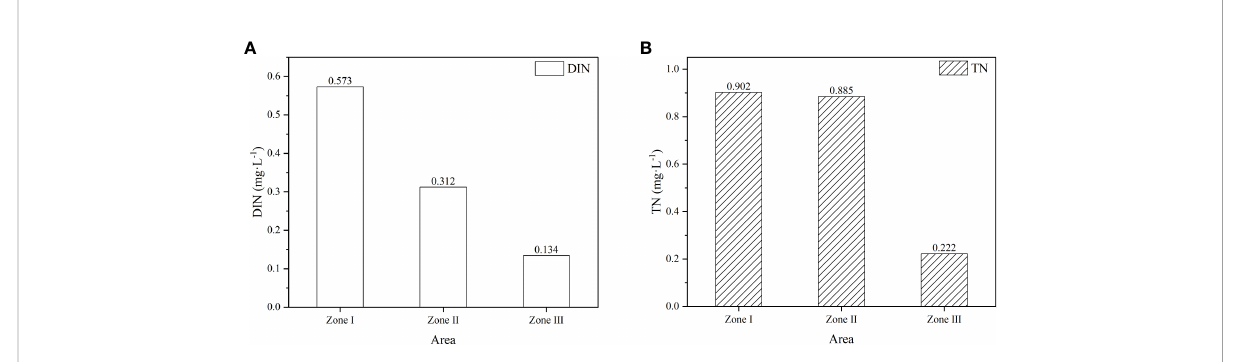
FIGURE 6 Recommended criteria for DIN (A) and TN (B) in the PRE coastal water.